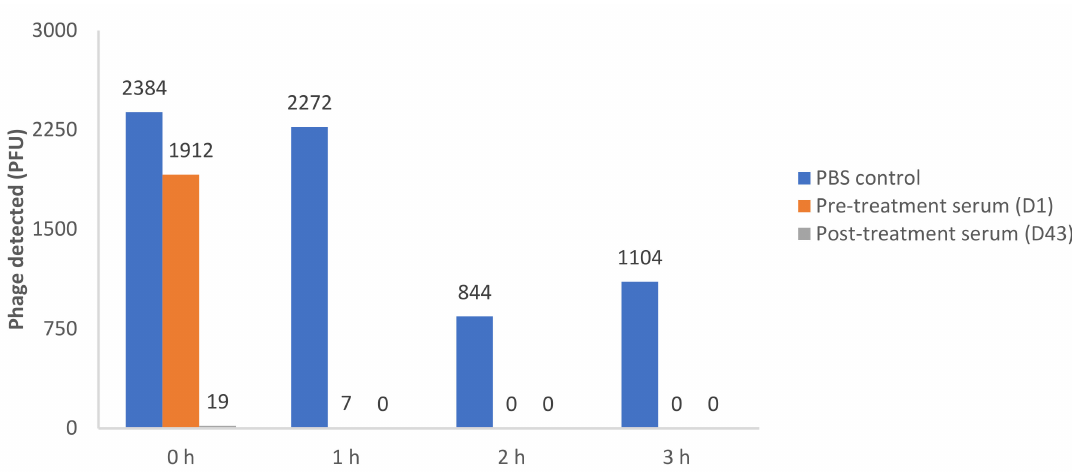
Figure 4. Recovery of viable phage after incubation with patient’s serum and 2.4 × 10 6 PFU of SaGR51ø1 phage. Phage concentration in the presence and absence of serum at 4 different time points (0, 1, 2 and 3 h). PBS: Phosphate buffered saline; D1: Day 1; D43: Day